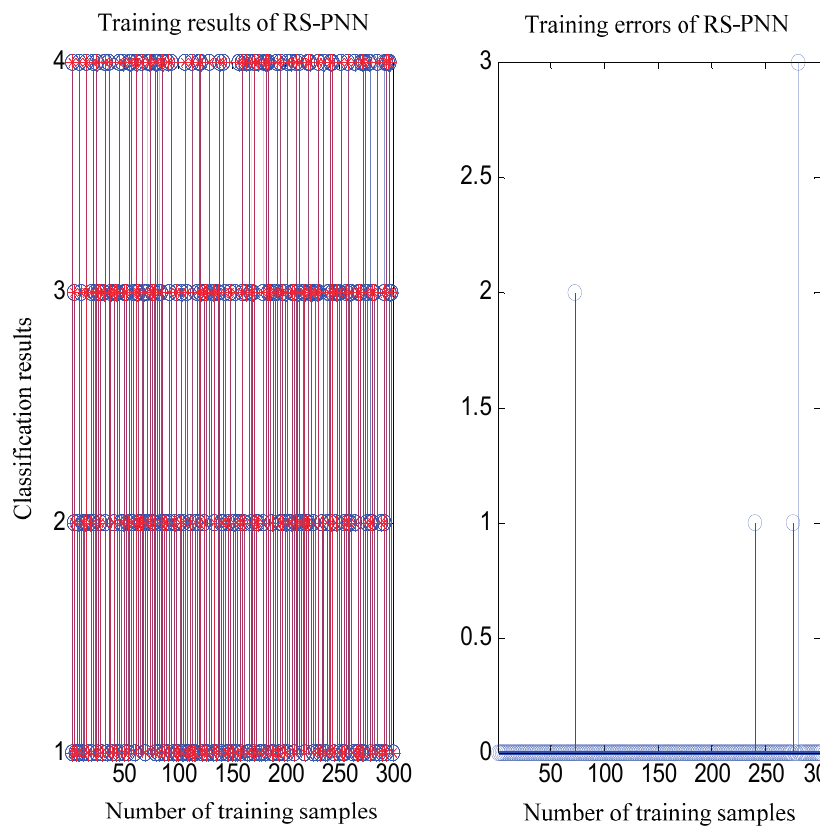
Figure 9. Classification results of RS-PNN under training